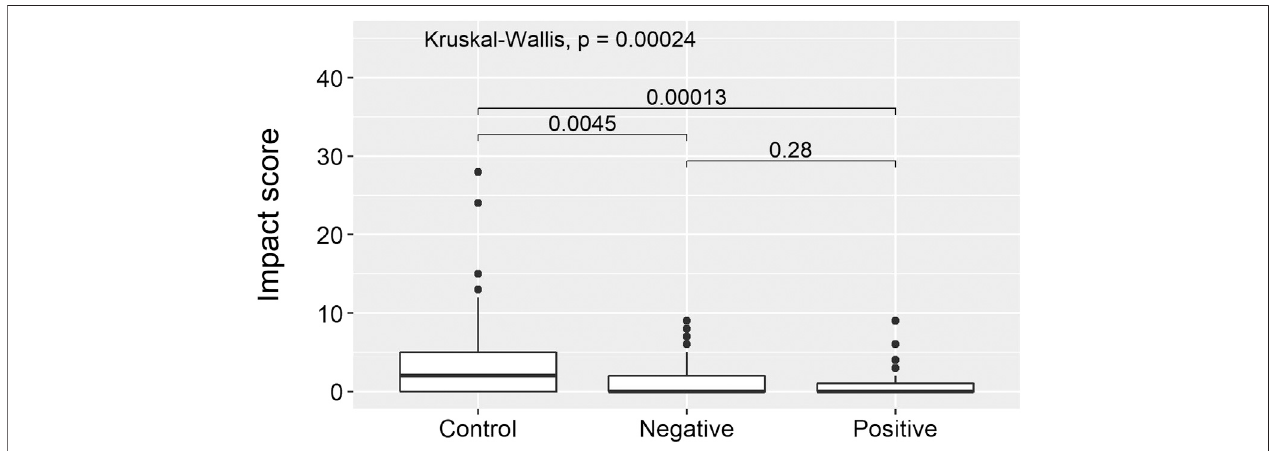
FIGURE 4 | The calculated impact score per treatment including the p -value resulting from the Kruskal-Wallis Rank Sum test and the p -values of Pair-wize Comparison Wilcoxon Rank Sum test. Boxes represent the interquartile range which contain 50% of the values. A line across the box indicates the median and fi lled circles are the